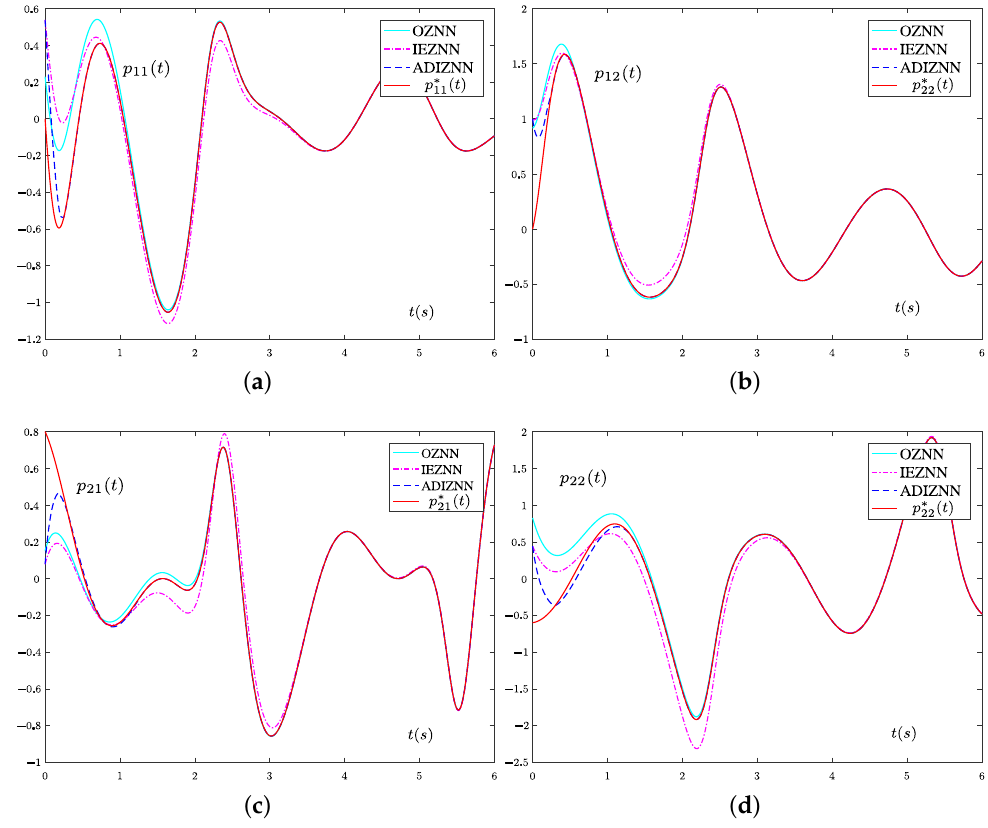
Figure 1. State trajectories of OZNN (9), IEZNN (12) and ADIZNN (19) for the DSE with (35) in the absence of the noise. ( a ) State trajectory of p 11 ( t ) . ( b ) State trajectory of p 12 ( t ) . ( c ) State trajectory of p 21 ( t ) . ( d ) State trajectory of p 22 ( t )